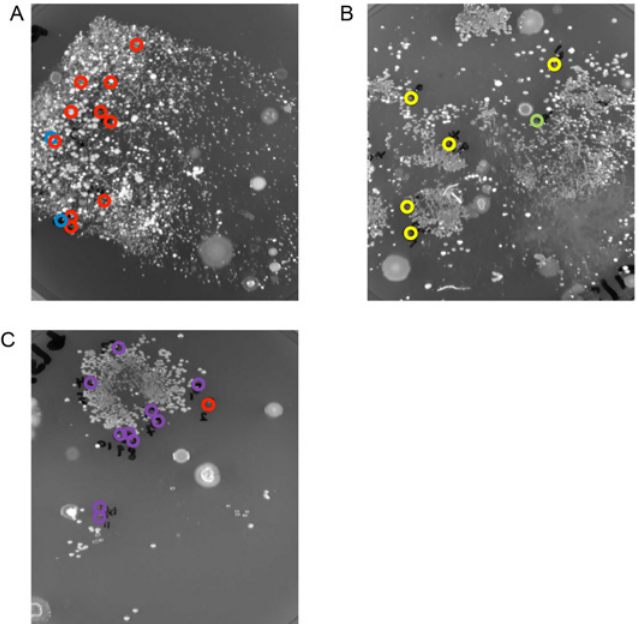
Figure 4. S. aureus wound topography in BU patients. Used dressings from wounds of BU patients were replica-plated onto CLED agar plates, and S. aureus colonies thus obtained were typed by MLVF. S. aureus colonies belonging to different MLVF clusters are shown in different colors: cluster A, red circles; cluster D, blue circles; cluster F, yellow circles; cluster H, green circle and cluster L, purple circles. (A) Replica plate of a wound dressing collected from patient 7 at time point t8 with S. aureus colonies belonging to clusters A and D, (B) Replica plate of a wound dressing collected from patient 7 at time t5 with S. aureus colonies belonging to clusters F and H. (C) Replica plate of a wound dressing collected from patient 22 at time t6 with S. aureus colonies belonging to clusters A and L.